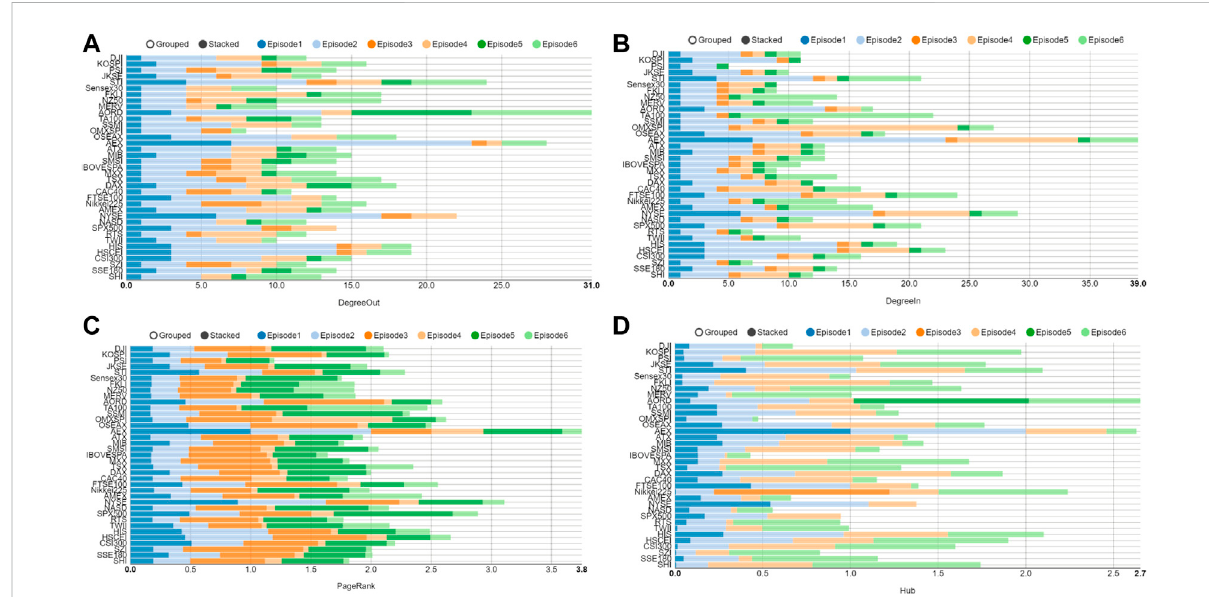
FIGURE 10 Parameters of each layer network at the time of the European subprime mortgage crisis. (A) The out-degree of each layer network; (B) The in- degree of each layer network; (C) The PageRank of each layer network; (D) The Hub each layer network.